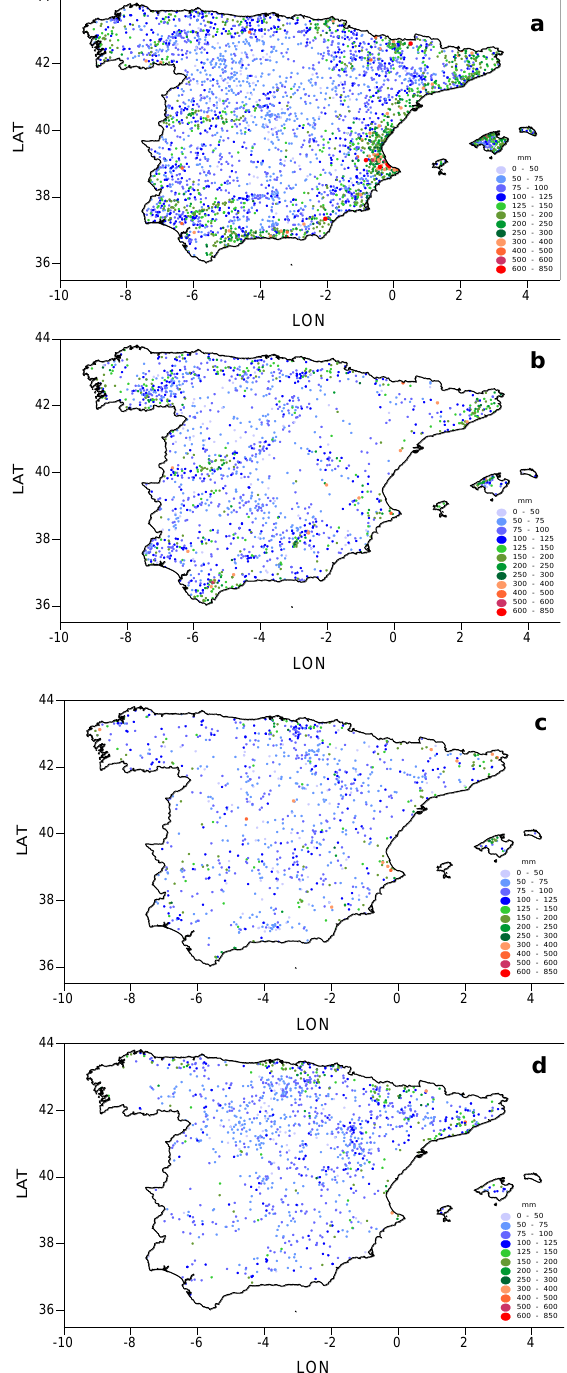
Fig. 5. Seasonal spatial distribution of extreme daily rainfall. (a) au- Figure 5.- Seasonal spatial distribution of extreme daily rainfall. a) autumn (4185 data); b) winter (1694 data); c) spring tumn (4185 data); (b) winter (1694 data); (c) spring (977 data); (977 data); d) summer (1279 data). (d) summer (1279